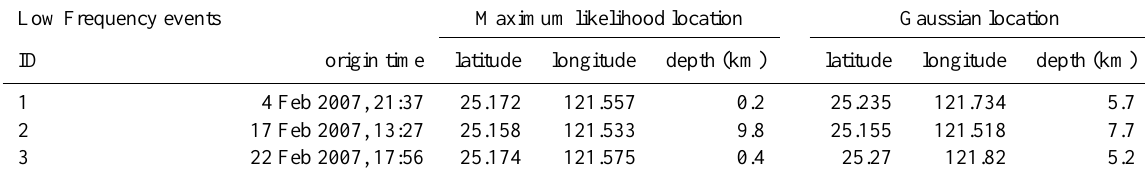
Table 1. Summary of location results for the three LF events identified during the study period.